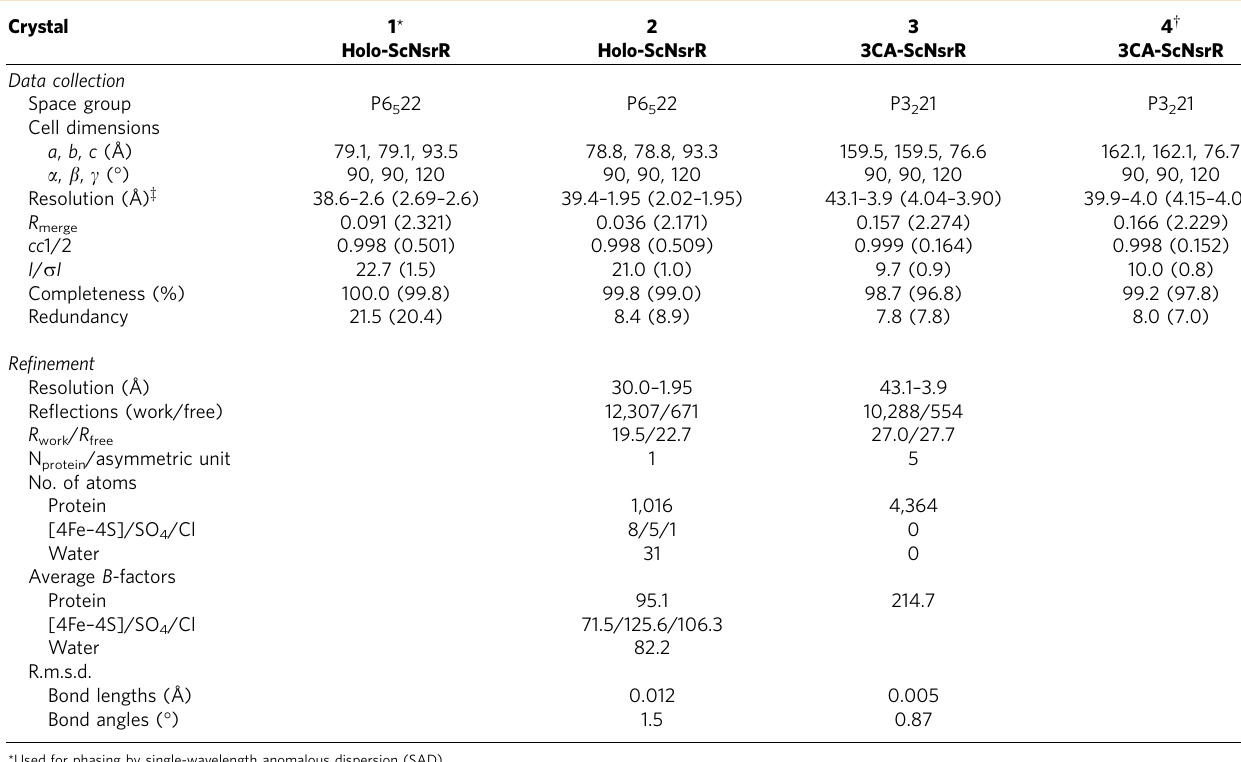
Table 1 | Data collection and refinement statistics.